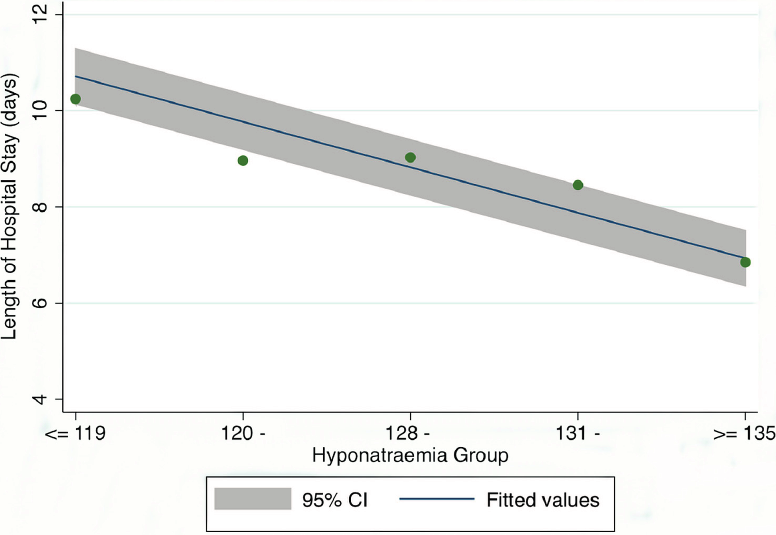
Figure 2. Relationship between Length of Hospital Stay (LOS) and admission sodium level. The Odds Rates of a death (compared with the ≥ 135 mEq/L group) increased as the Na level fell thus: 131 mEq/L + IRR 1.25 (95% CI 1.22, 1.29), 128 mEq/L ± IRR 1.36 (95% CI 1.30, 1.42), 120 mEq/L ± IRR 1.35 (95% CI 1.29, 1.42) and <119 mEq/L ± IRR 1.54 (95% CI 1.40,